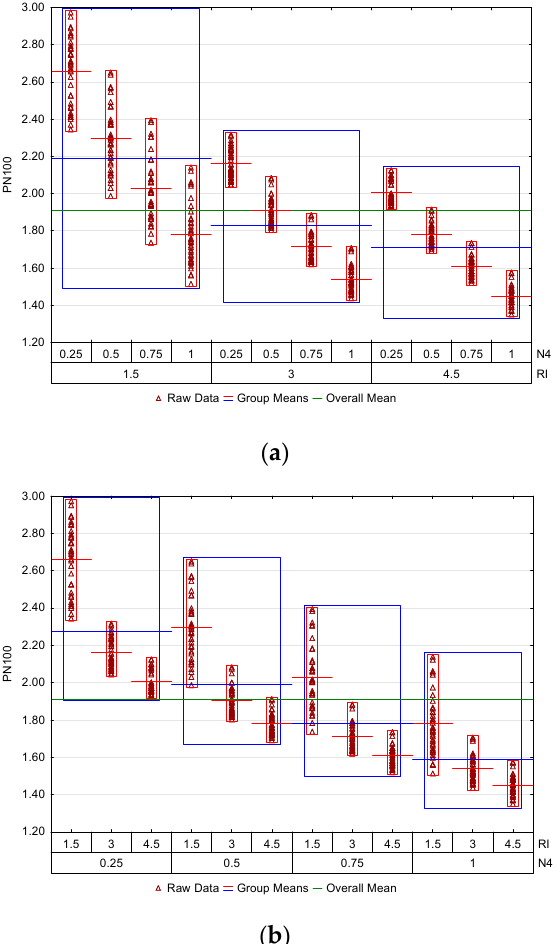
Figure 9. Variability plots of PN100 illustrating: ( a ) N4 impact for various RI; ( b ) RI impact for various N4.